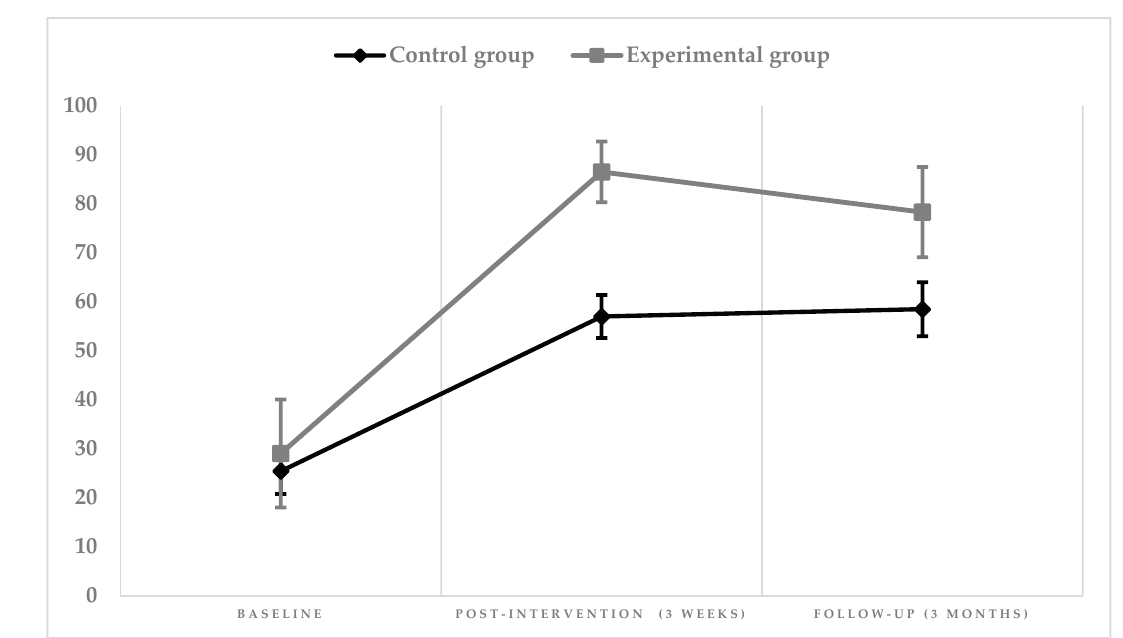
Figure 3. Graphic representation of the intervention’s effect on EQ-VAS. The differences in the EQ-5D-5L HRQoL results between groups are shown in Table Table 3. Difference in the EuroQoL-5 dimensions instrument (EQ-5D-5L) frequency distribution according to intervention group. EuroQoL-5 Dimensions